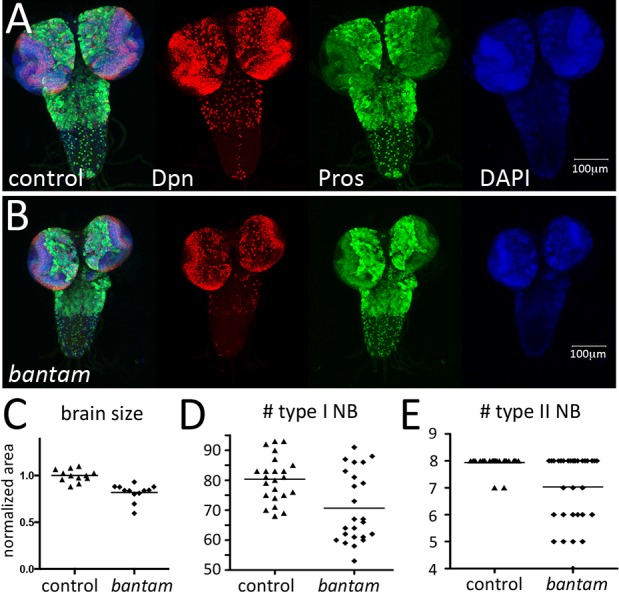
bantam is required for larval central brain growth. (A,B) Overview of bantamΔ1/+ heterozygous control and bantamΔ1/Δ1 homozygous mutant brains at late third instar larval stage. Neural progenitors were labeled with anti-Dpn (red), neural progeny were labeled with anti-Pros (green) and DNA was labeled with DAPI (blue). (C) Brain area was measured from confocal micrographs using ImageJ. Data for the mutant were normalized to the average of the control brains. n=14 brains/genotype. P<0.0001, Mann–Whitney test. (D,E) Number of type I and type II NB (per brain lobe) in bantamΔ1/+ (control) and bantamΔ1/Δ1 homozygous mutants in late third instar. (D) Average=80 for control versus 71 for the mutant. n=24 brains/genotype. P=0.004, Mann–Whitney test. (E) Average=8 for control versus 7 for the mutant; n=32 brains/genotype; P=0.0002, Mann–Whitney test. Horizontal line: mean value.